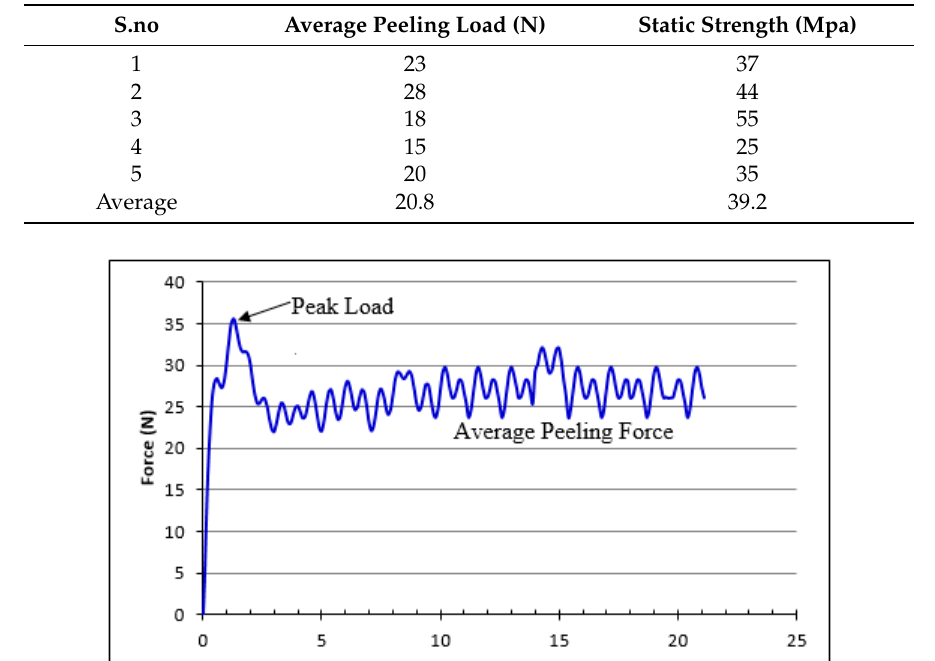
Table 7. Aluminum-carbon fiber/epoxy bond normal strength results.